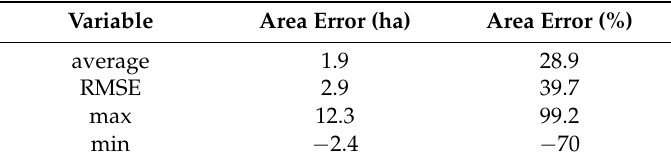
Table 3. Summary statistics of the area error and percentage area error of the harvesting site representations on the FCLE compared to the manually delineated harvesting